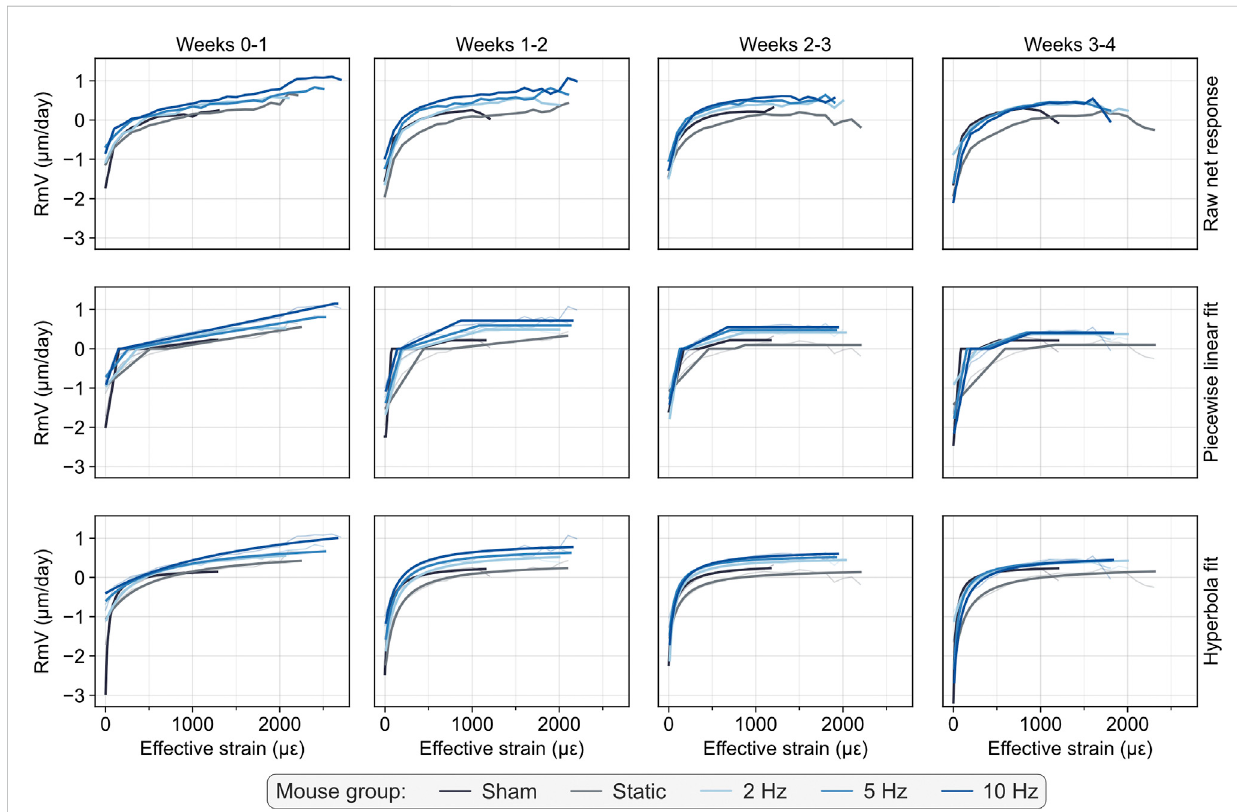
FIGURE 3 Estimation of the mechanostat (re)modeling velocity (RmV) curve from time-lapsed in vivo micro-CT imaging data, illustrated with the average raw net response (top row) per group, the fi tted piecewise linear functions (middle row), as described in the mechanostat theory and continuous hyperbola functions (bottom row). Data points are fi ltered such that at least three mice are averaged for each mechanical signal value. Mechanical signal values obtained from micro-FE analysis using homogeneous material